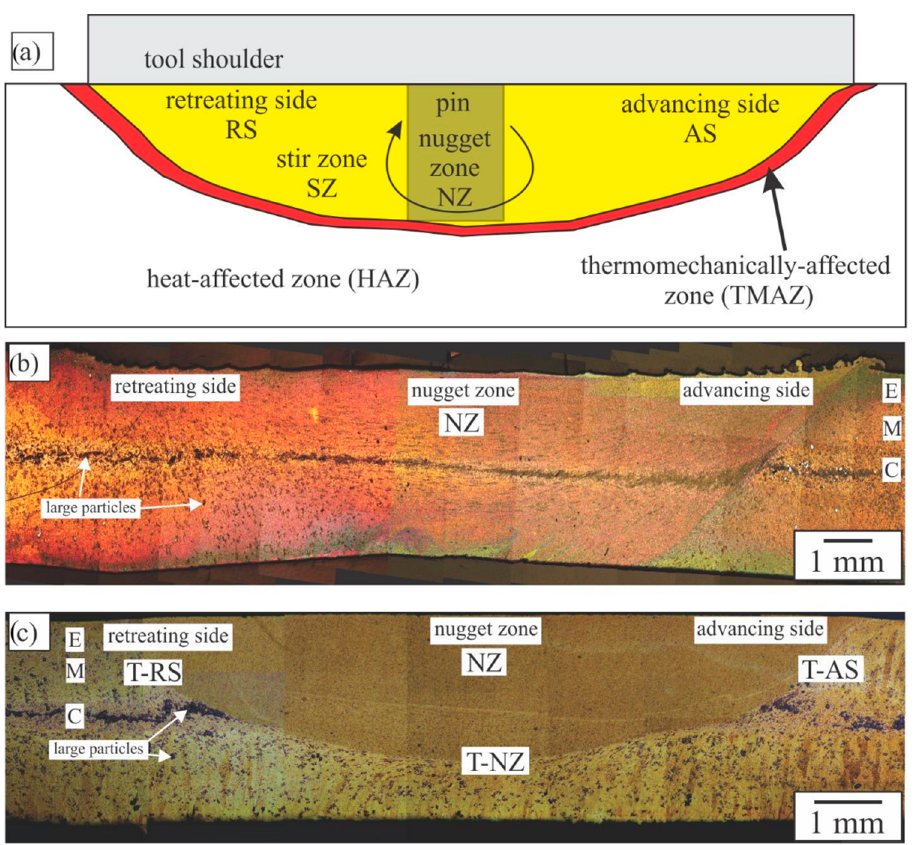
Figure 2. Cross-sections of the processed regions. ( a ) Schematic presentation of different areas. The composed light micrograph of the Al–Mn–Cu–Be alloy after FSP with ( b ) FSP95 and ( c ) FSP950. (E—edge, M—middle, C—centre, NZ—nugget zone, T-RS—transition retreating side, T-AS—transition advancing side, T-NZ—transition nugget zone).